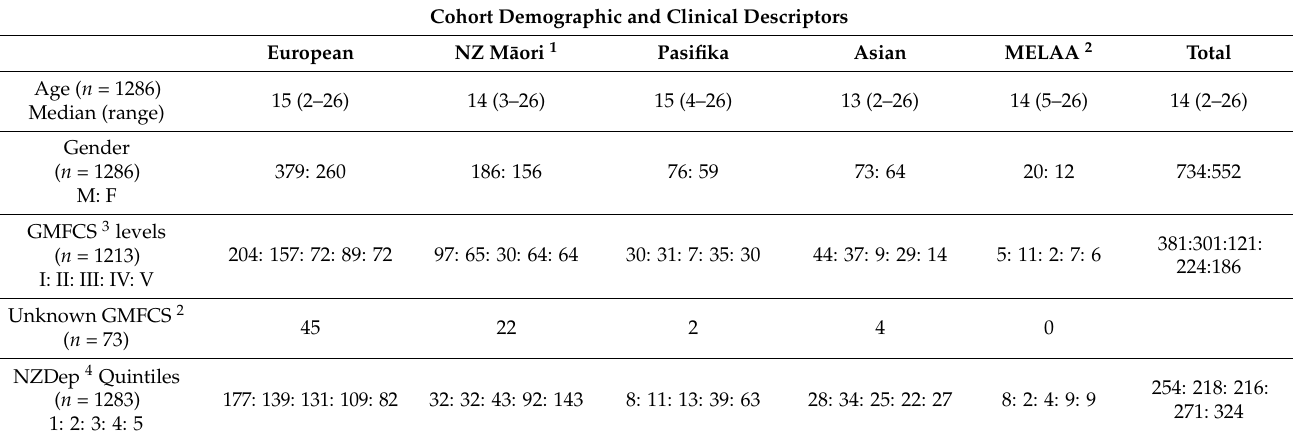
Table 1. Demographics of the Study Participants, including median age and gender distribution, GMFCS, and NZDep quintile distribution by ethnic